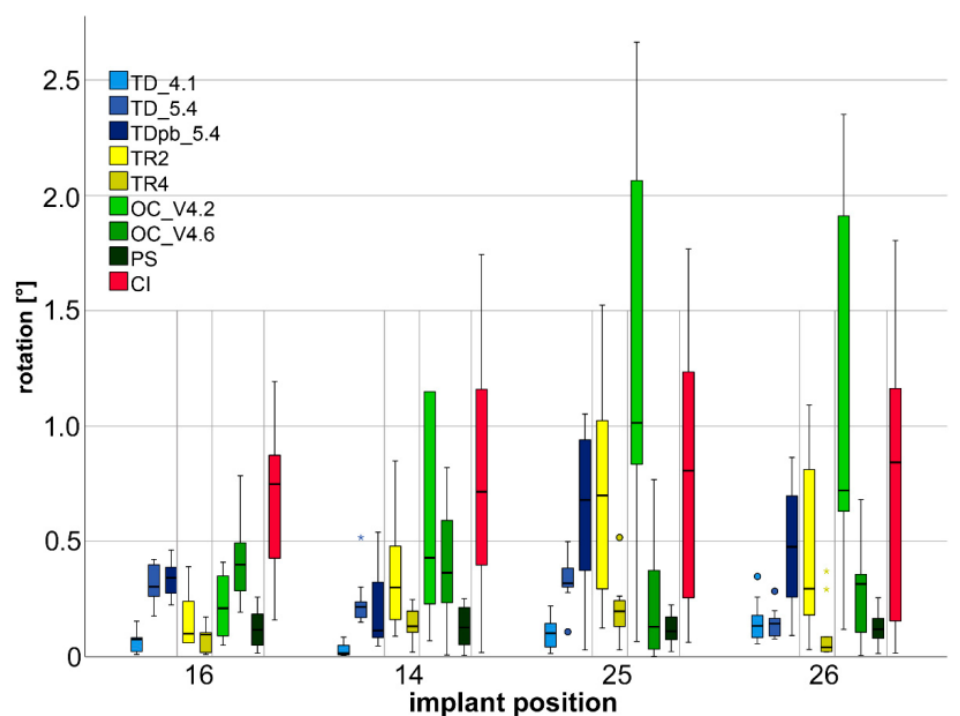
Figure 4. Results for the rotational deviations for the implant positions for each intraoral scanner